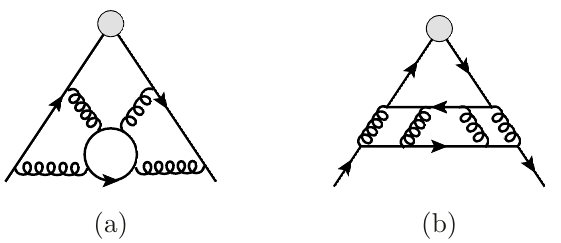
Figure 1 . Non-singlet (a) and singlet (b) sample diagrams contributing to the colour structure ( d abcd ) 2 of the photon-quark form factor. The gray blob indicates the external vector current. F